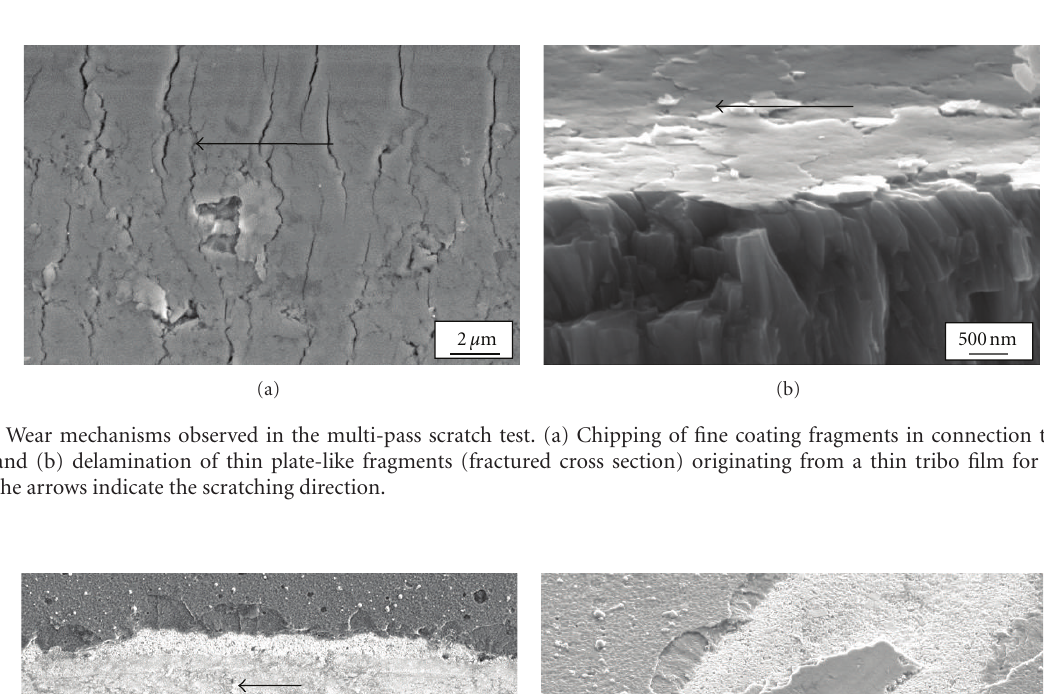
narrow band corresponding to chipping and local interfacial spalling. The narrow band signifies a quick transition from plastic deformation, minor cracking and wear via local interfacial spalling to continuous interfacial spalling with increasing normal